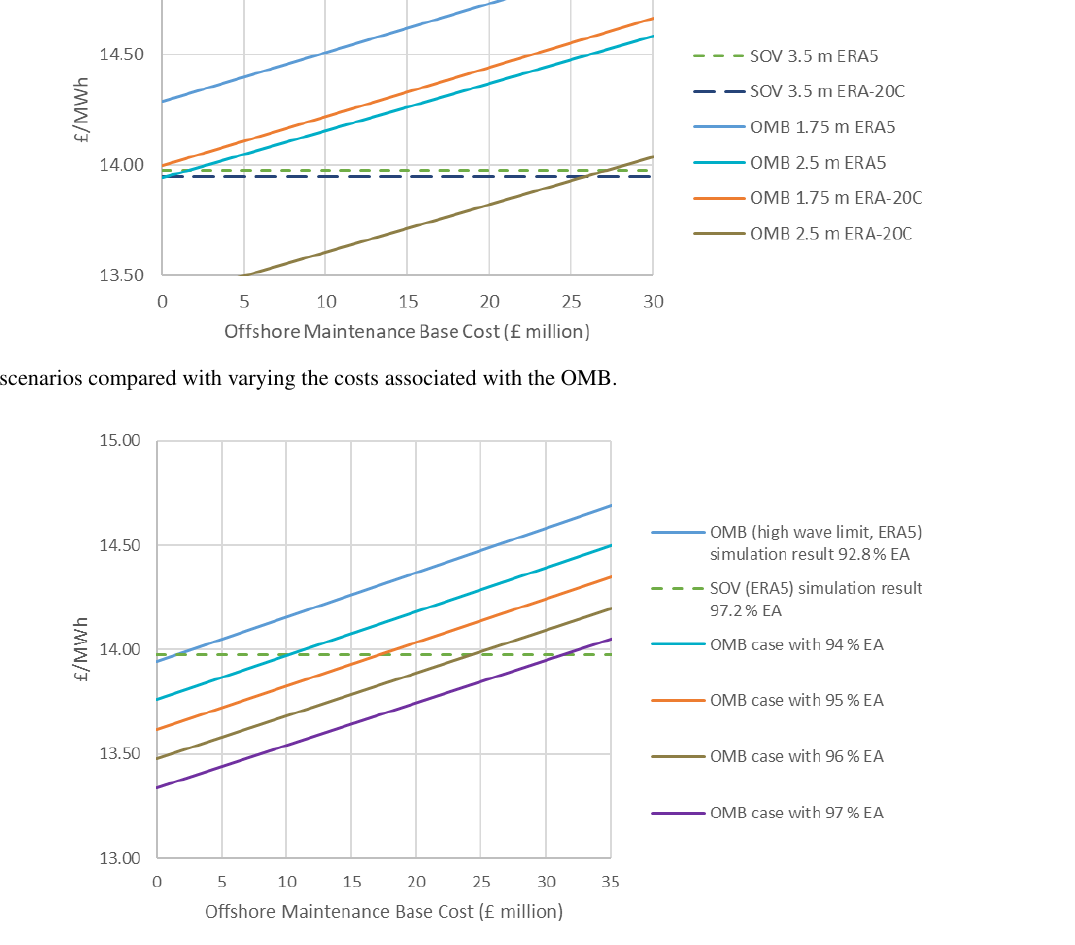
Figure 8. The effect of changing energy availability on the results.